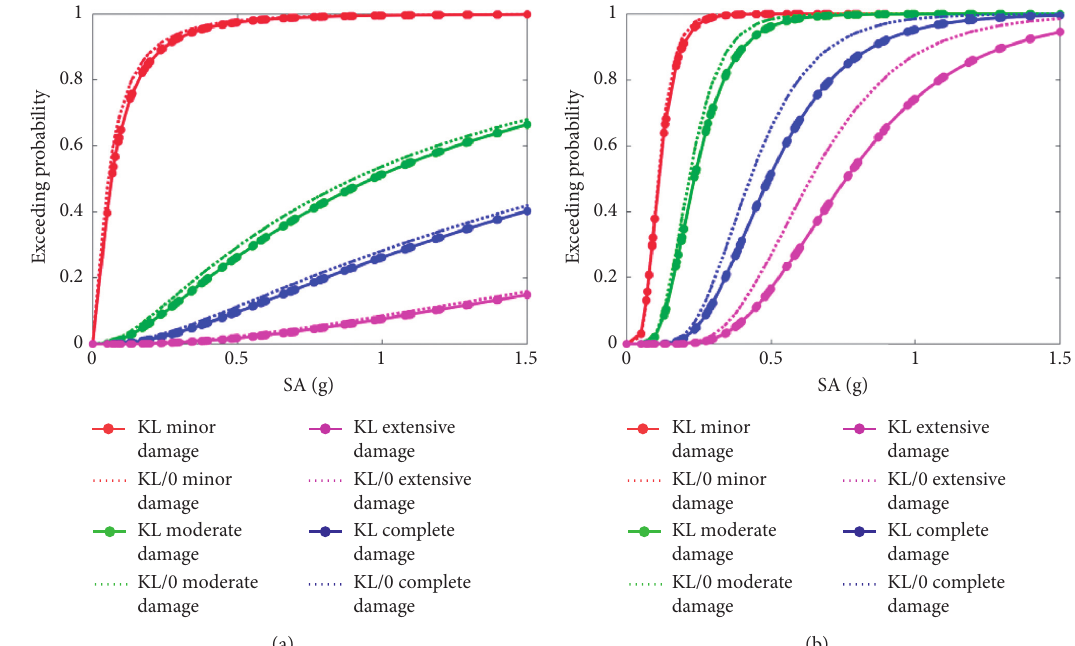
Figure 7: Fragility curves of bearings. (a) 1 # bearing. (b) 2 #